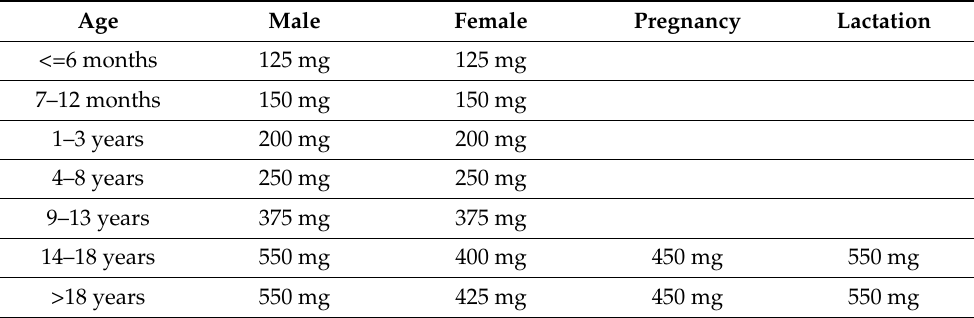
Table 3. Daily adequate intakes for